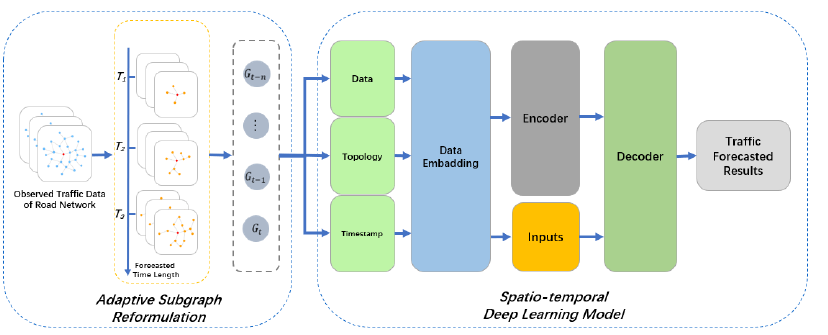
Figure 1. The structure of traffic forecasting framework with adaptive subgraph reformulation.